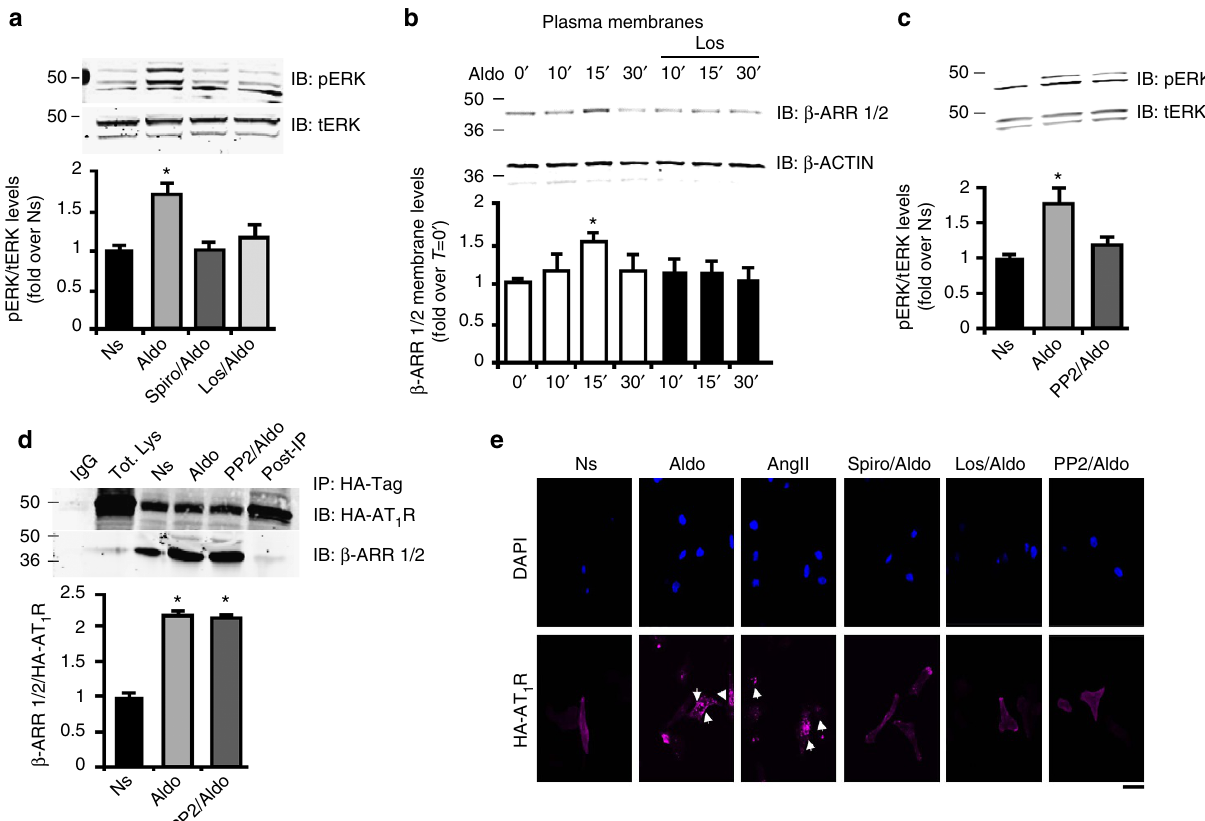
Figure 1 | Aldosterone-mediated cross-talk between the MR and the AT 1 R. ( a ) Representative immunoblots (upper panels) and densitometric quantitative analysis (lower panel) of multiple ( n ¼ 3) independent experiments to evaluate ERK 1/2 phosphorylation (pERK) as a ratio of activated ERK to total ERK (tERK) in neonatal rat ventricular myocytes (NRVMs) either unstimulated (Ns) or stimulated with aldosterone (Aldo 1 m M) for 15min. Before Aldo treatment, myocytes were pre-treated with spironolactone (Spiro 10 m M) or losartan (Los 10 m M) for 30min; * P o 0.05 versus Ns. ( b ) Representative immunoblots (upper panels) and densitometric quantitative analysis (lower panel) of multiple ( n ¼ 3) independent experiments to evaluate b -arrestin membrane recruitment in crude plasma membrane preparations from NRVMs. Shown is a time course (0–30min) of Aldo (1 m M) treatment alone or with 30min pre-treatment with Los (10 m M). b -ACTIN was used as loading control; * P o 0.05 versus Ns. ( c ) Representative immunoblots (upper panels) and densitometric analysis (lower panel) of multiple ( n ¼ 3) independent experiments to evaluate pERK in NRVMs Ns or stimulated with Aldo (1 m M) for 15min. Before Aldo, a group of cells was pre-treated with PP2 (10 m M) for 30min. tERK was used as loading control; * P o 0.05 versus Ns. ( d ) Representative panels (upper panels) and densitometric analysis (lower panel) of multiple ( n ¼ 3) independent experiments of Co-IP assay in total lysates from NRVMs infected with HA-tagged AT 1 R. Cells were Ns or stimulated with Aldo (1 m M) for 30min. Before stimulation, a group of cells was pre-treated with the c-Src inhibitor PP2 (10 m M). Immunoprecipitated proteins (IP) for HA-tag were blotted with an antibody anti- b -arrestin 1/2 antibody; * P o 0.05 versus Ns. ( e ) Representative immunofluorescence images of NRVMs infected with HA-tagged AT1R (red, lower panels). DAPI-stained myocyte nuclei are shown in the upper panel of images. Shown are cells treated for 30min with Aldo (1 m M) or AngII (1 m M) or before Aldo, pre-treated for 30min with Spiro (10 m M), Los (10 m M) or PP2 (10 m M). Arrows indicate receptors that are internalized. Scale bar, 20 m m. ( a – d ) Statistical significance between groups was determined by one-way ANOVA with Bonferroni post hoc correction. All data are shown as mean ± s.e.m. NATURE COMMUNICATIONS|7:10877|DOI: